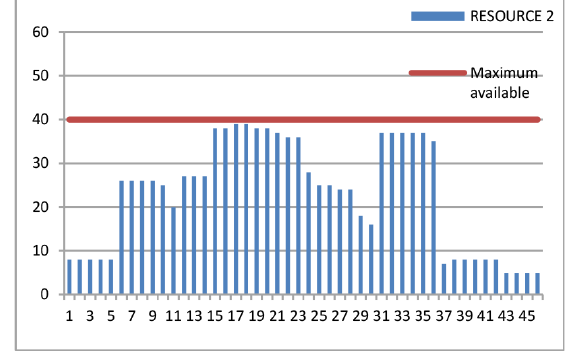
Figure 31. Daily usage of resource 2 throughout the calendar of the project (before using the method)-Experiment 2